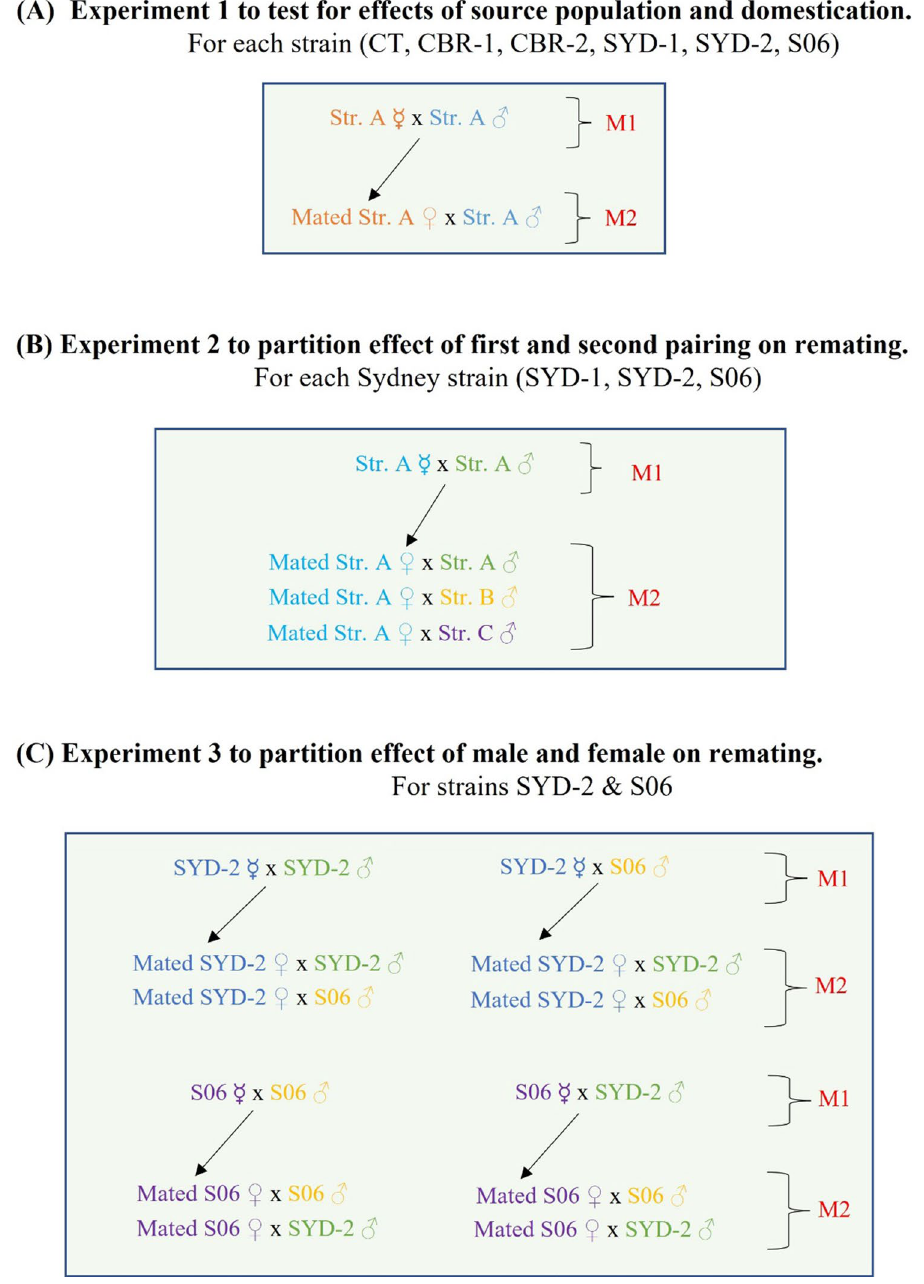
Figure 1. Schematic representation of the mating and remating schemes for the three Experiments. Panels (A) , (B) and (C) cover Experiments 1, 2 and 3